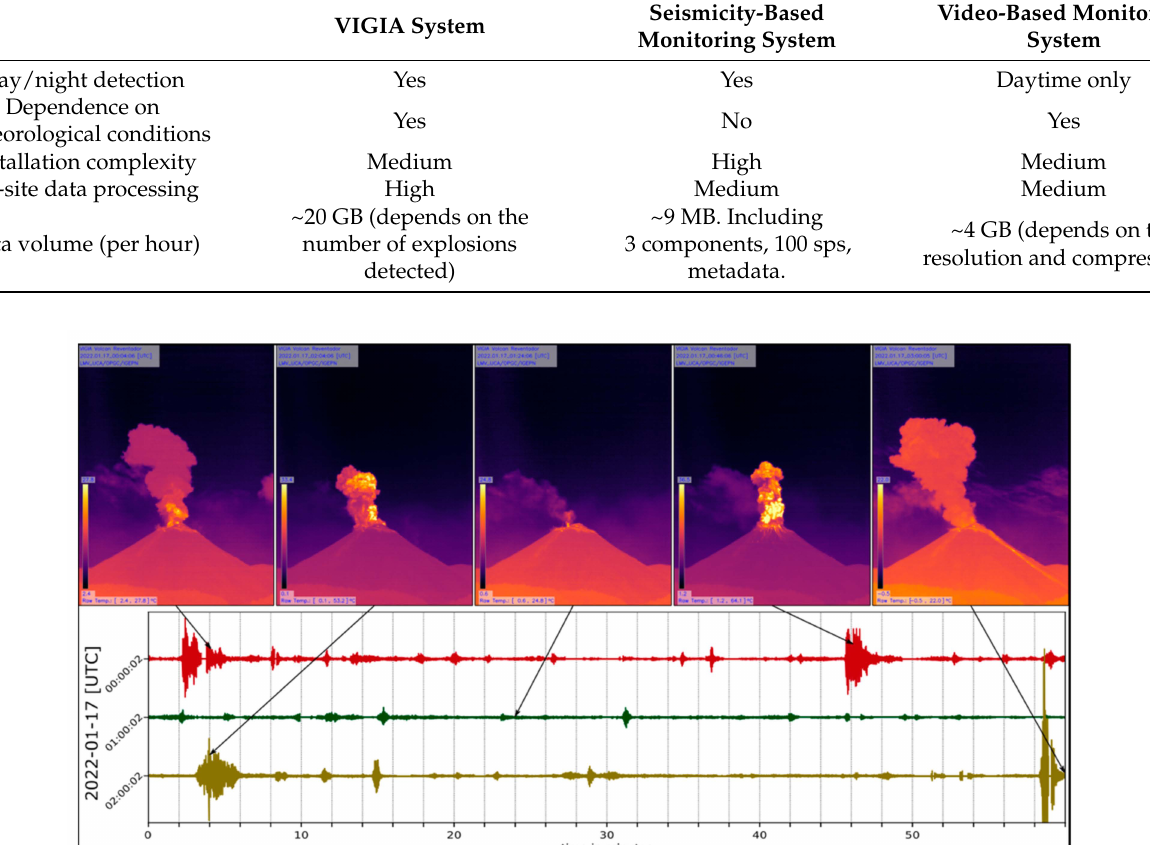
Figure 9. Infrared thermal still images obtained by VIGIA provide visible information of the state of the volcano over time. The lower panel contains an extract of the seismic record from the REVN seismic station located ~4 km from the current active vent of the Reventador volcano. This example from 2022–01–17 shows thermal images with a precise time stamp that complement the information obtained from the seismic record to describe the surficial activity of the volcano. One second of thermal video file contains, in the case of VIGIA, 32 images of 640 × 480 pixels, which use 18.75 MB of disk space. This means that one hour of continuous thermal video takes up about 66 GB, and one day will use 1582 GB (1.5 TB). Continuous acquisition ering periods where the view of the volcano is impeded by clouds, which, in the case of recording of thermal videos only when an explosion is detected. The videos are 49 s in duration (four seconds before the trigger plus 45 s after it), which uses around one GB of storage space. During an average day, in terms of volcanic activity and cloud conditions, the system identified 46 explosions, recording 41 GB of thermal video